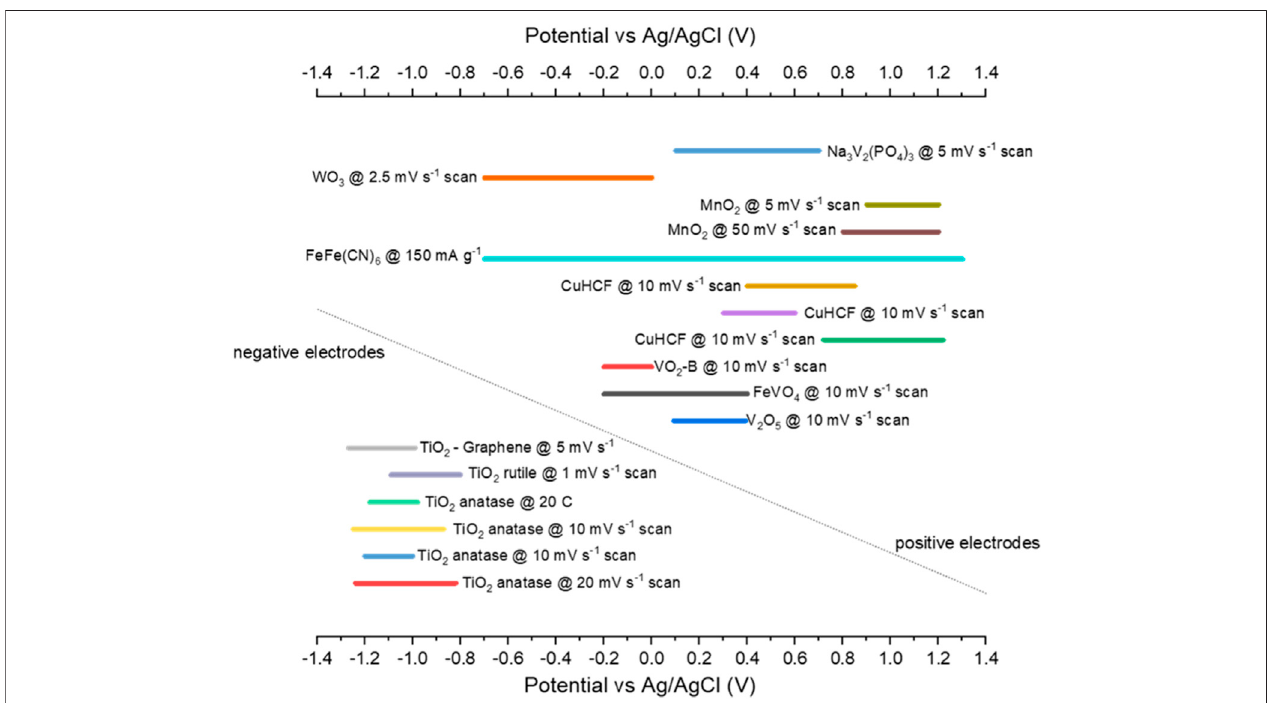
FIGURE 7 | Potential ranges reported for various half-cells converted to Ag/AgCl (Liu et al., 2012; Liu et al., 2014; Holland et al., 2018a; Holland et al., 2019; Holland, 2018; Zhao et al., 2019; Kumar et al., 2019; Zhao et al., 2020; Cai et al., 2020; Holland et al., 2018c; Zhou et al., 2019; Liu et al., 2015; Joseph et al., 2019; Joseph et al., 2020; Lahan and Das, 2019b; Lahan et al., 2017; Nacimiento et al., 2018).